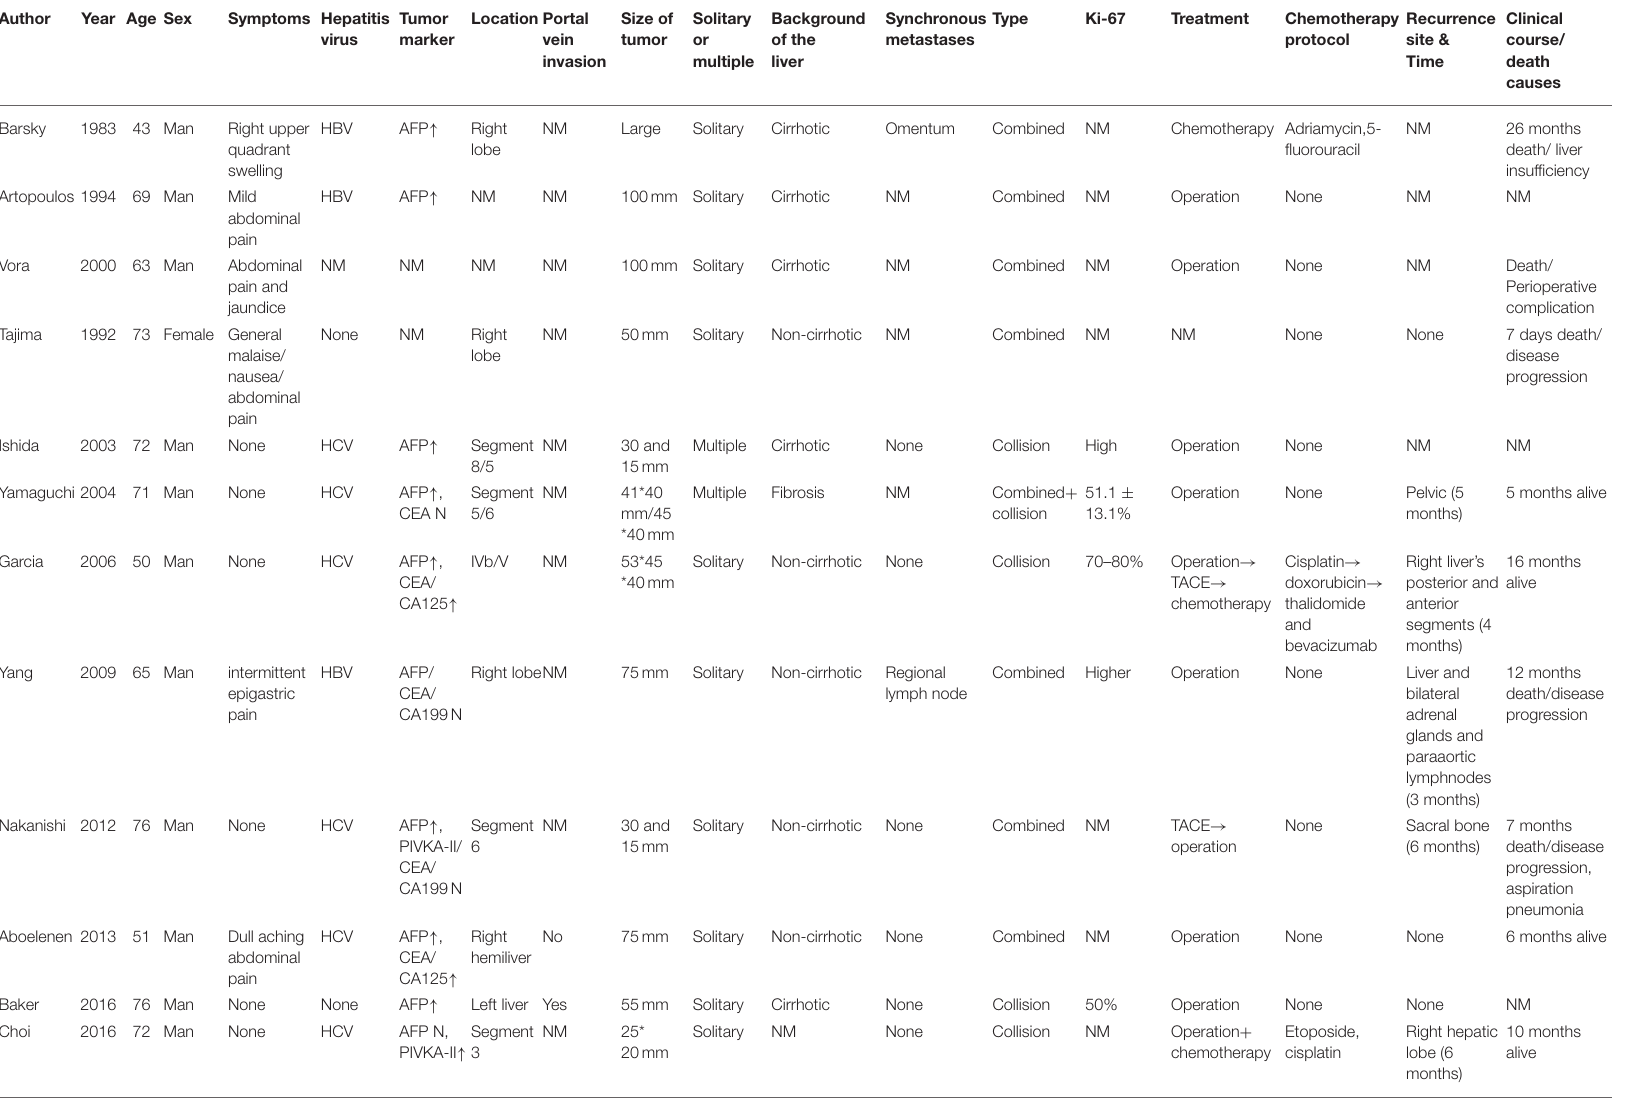
TABLE 1 | Summary of reported